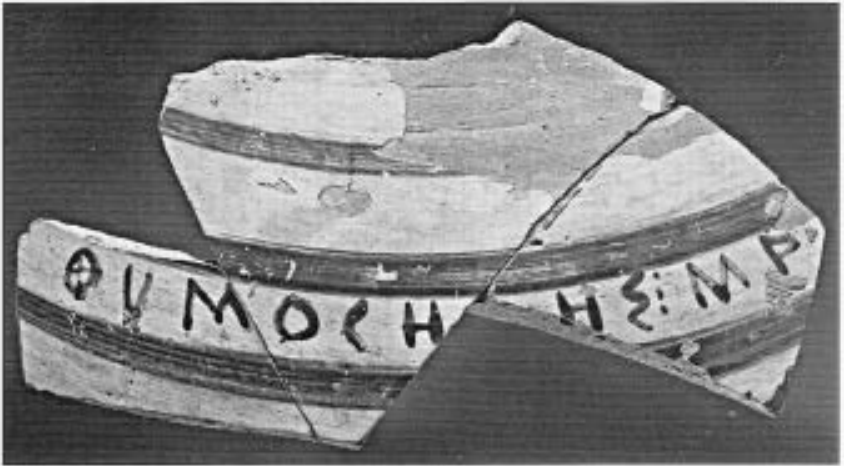
Figure 2 Fragments of a large Chian bowl or lid (600-575 BC) with a pre-firing dedica­ tory inscription of one Thymogethes, found at Naukratis; the joined fragments are in the British Museum and UCL's Classical Archaeology collection.